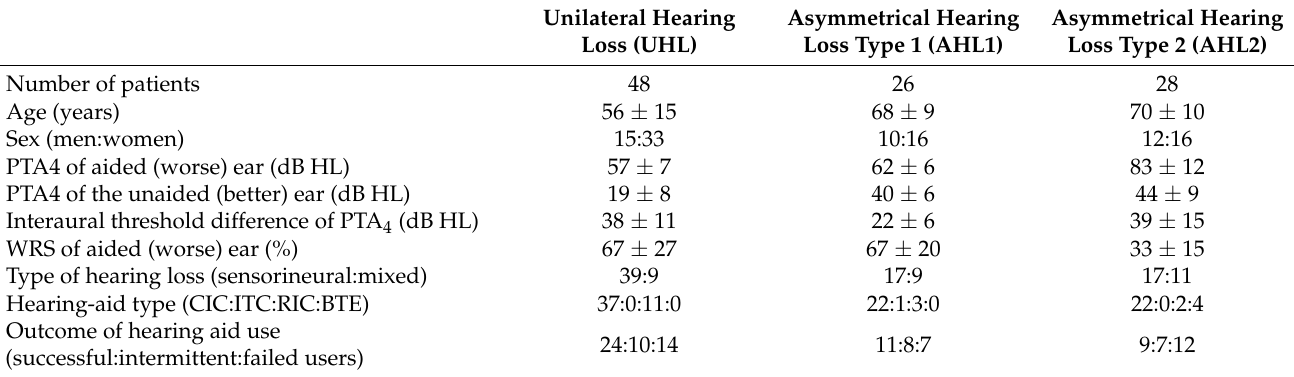
Table 2. Demographic data for the three AHL subgroups of 102 cases (expressed as the mean ± SD).